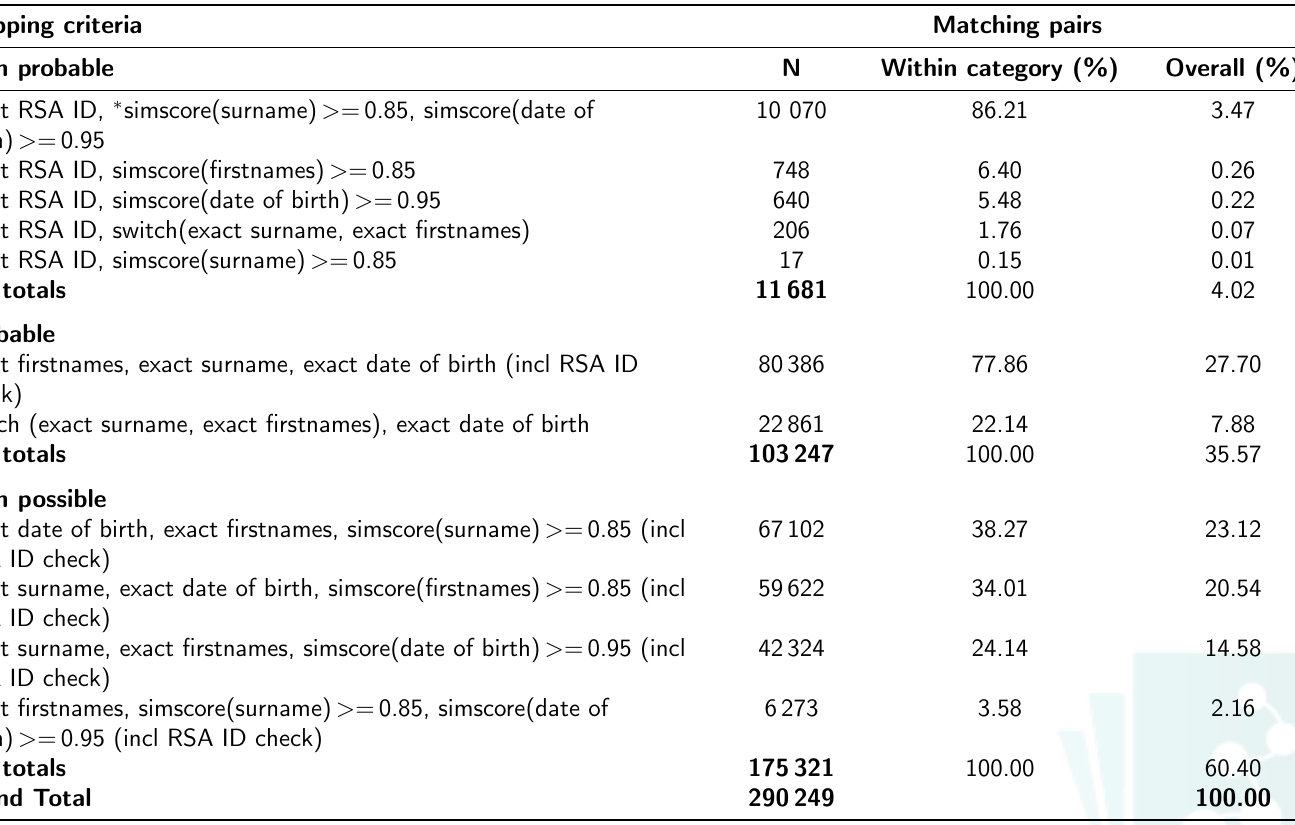
Table 1: Distribution of duplicates identified between 2015 and 2020 by linkage criteria Mapping criteria Matching